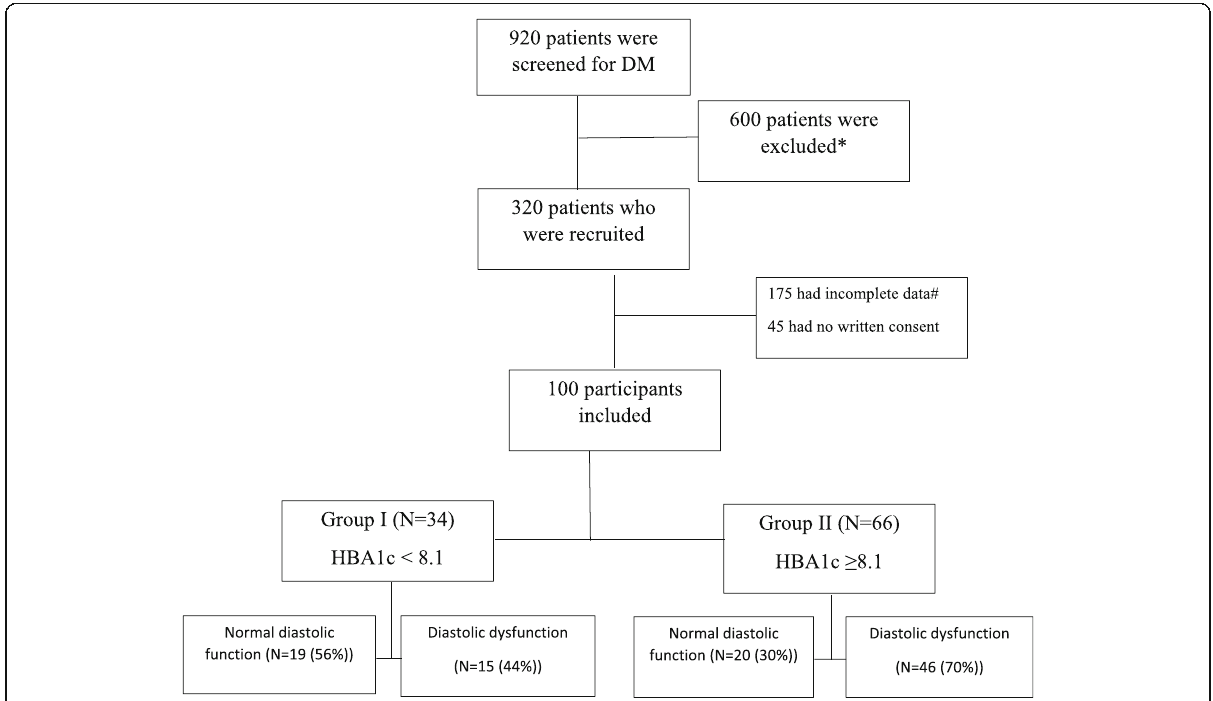
Fig. 1 Flowchart illustrating the presence of diastolic function in the study group according to glycated HbA1c. DM, diabetes mellitus. *Patient exclusion criteria are mentioned in details in the manuscript. #Incomplete ECHO data due to bad window or unclear documentation and lack of complete laboratory results were